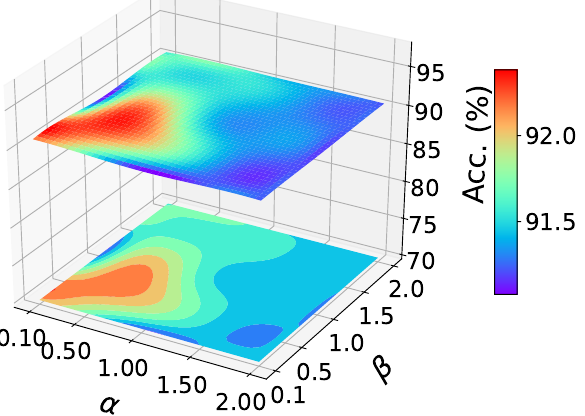
Figure 3. Parameter sensitivity study of task A → W, office-31.